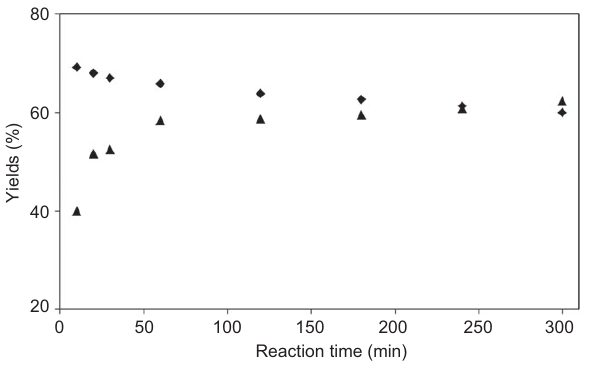
Figure 5 Optimization of VO(acac) N] 2